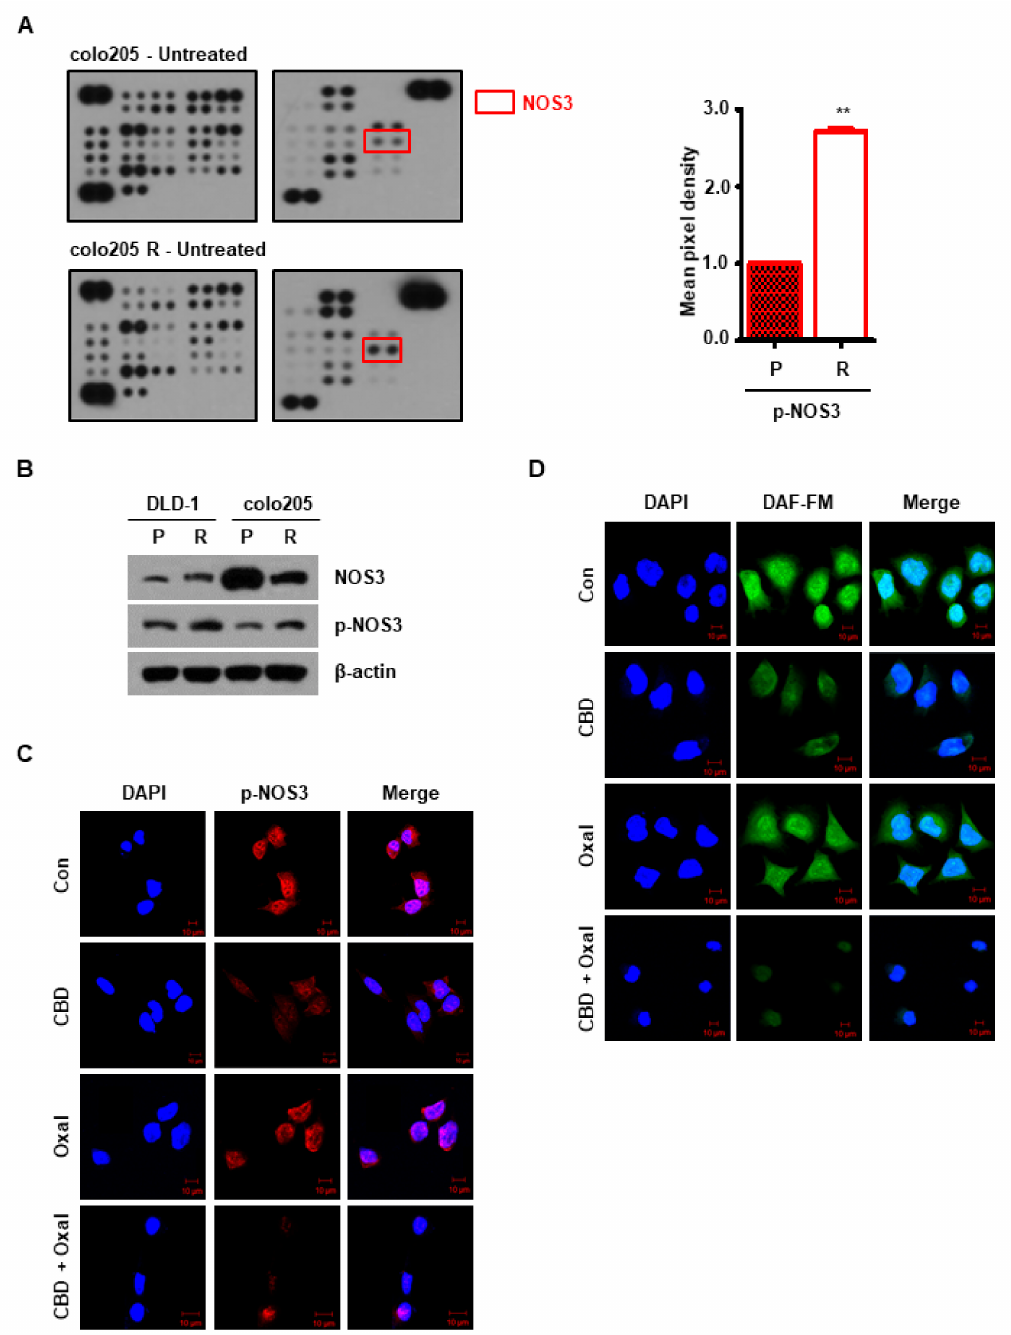
Figure A2. Decreased NOS3 activity induced by CBD in oxaliplatin-resistant cells inhibits NO production. ( A ) The Phospho-Kinase Array Kit was used to assay colo205 and colo205 R cells (left). The graph represents the quantification of mean pixel density of phopho-NOS3 using the Image J program (right). ** p < 0.01. ( B ) The levels of NOS3 and phopho-NOS proteins in parent and oxaliplatin-resistant CRC cells. ( C , D ) DLD-1 R cells were stained for ( C ) phopho-NOS3 or with ( D ) the DAF-FM dye following treatment with oxaliplatin and CBD. Images were captured using a confocal microscope (scale bar, 10 µ